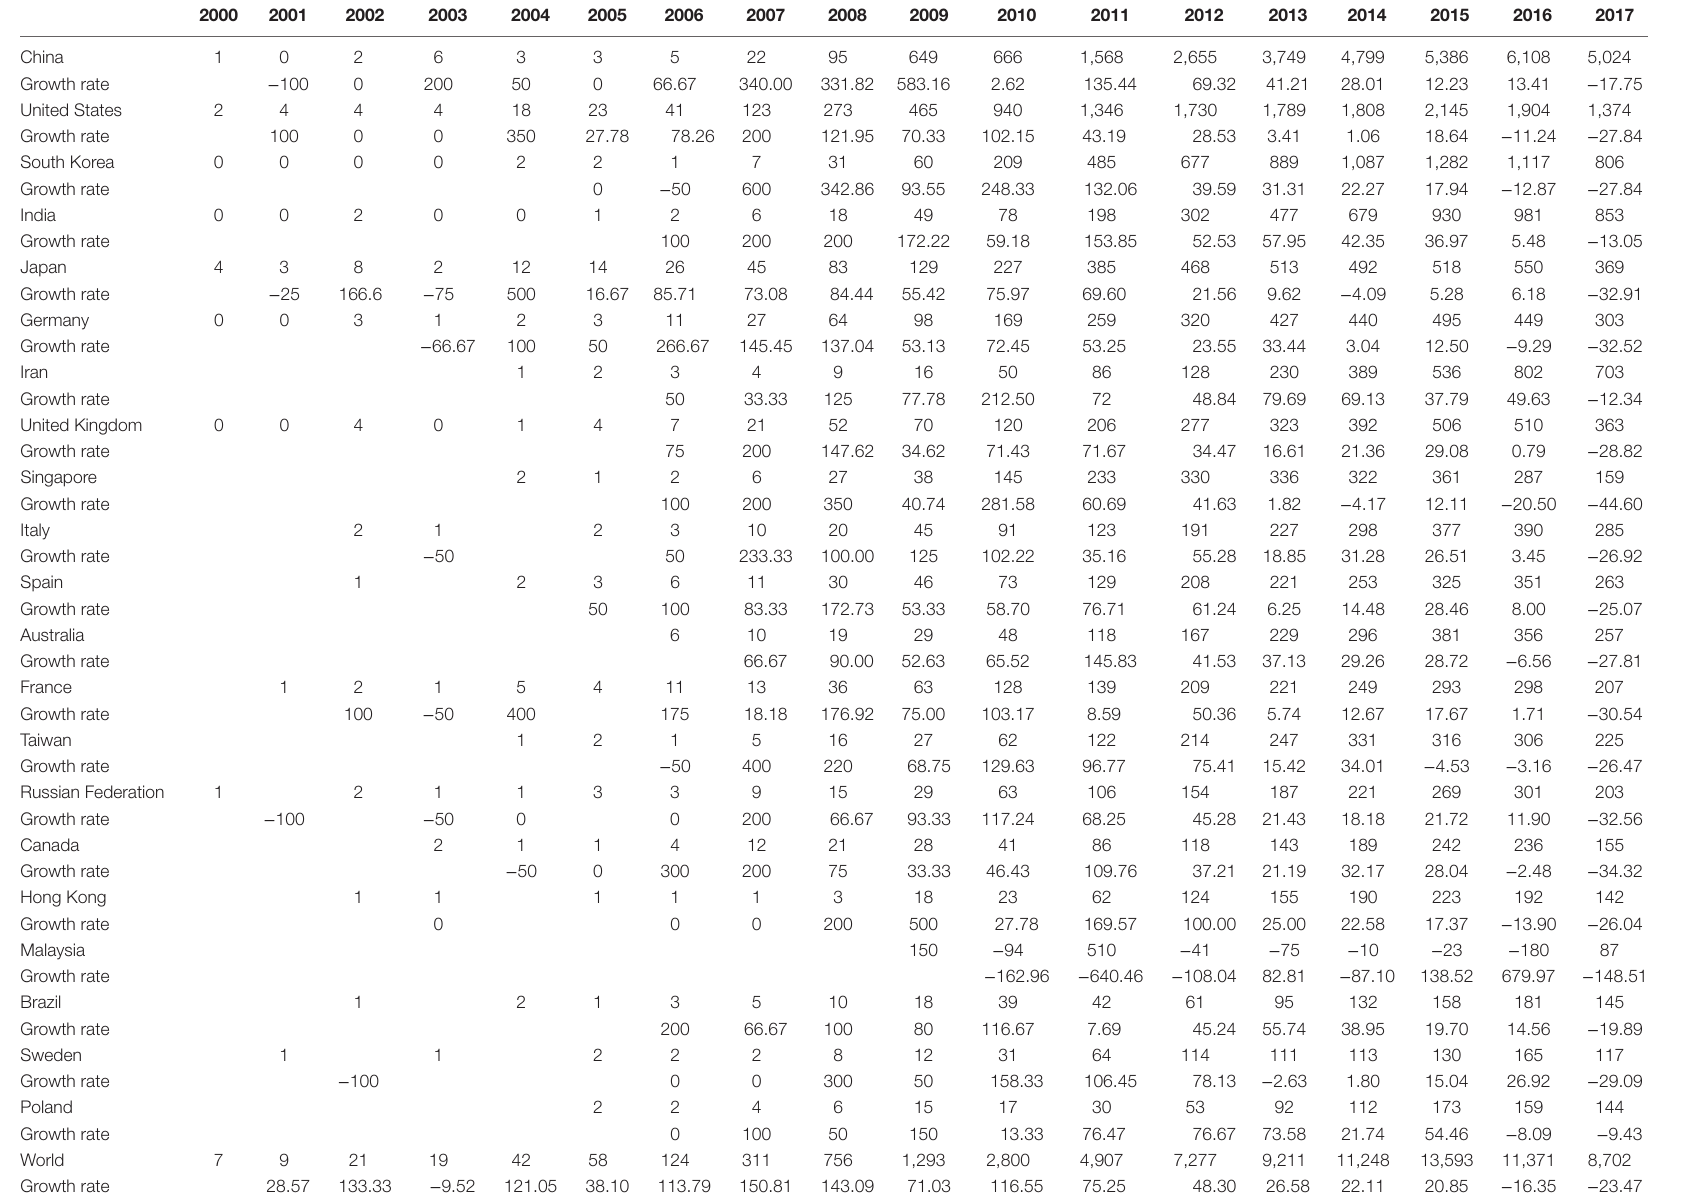
TaBle 1 | Evolvement of scholarly production on graphene by the top 20 countries worldwide.